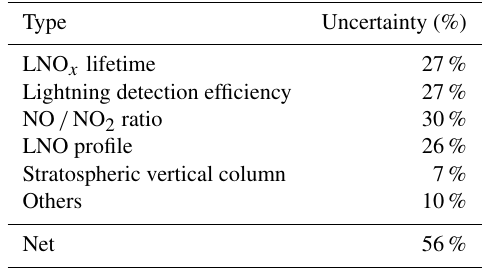
Table 2. Uncertainties for the estimation of LNO x production effi-